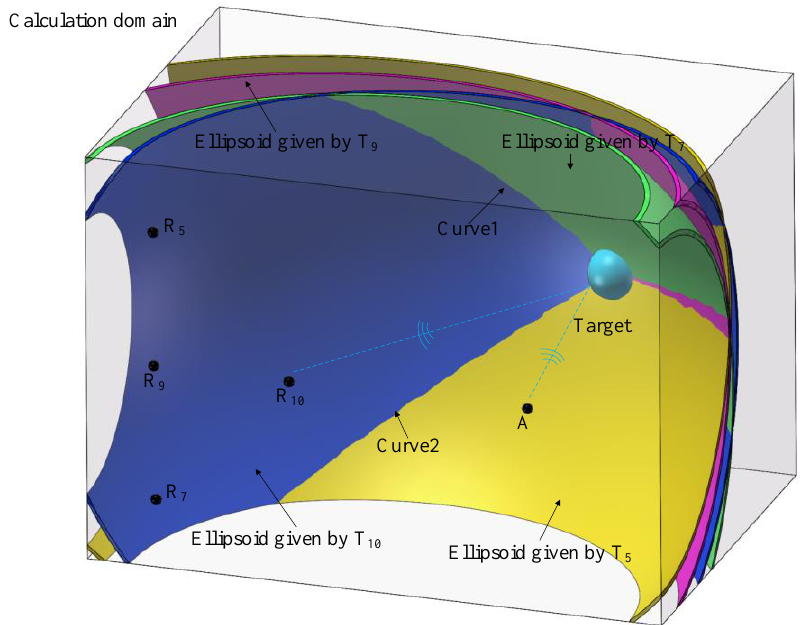
Figure 3. Target localization result using the traditional ToF-based method. Four ellipsoids are given by accurate ToF.